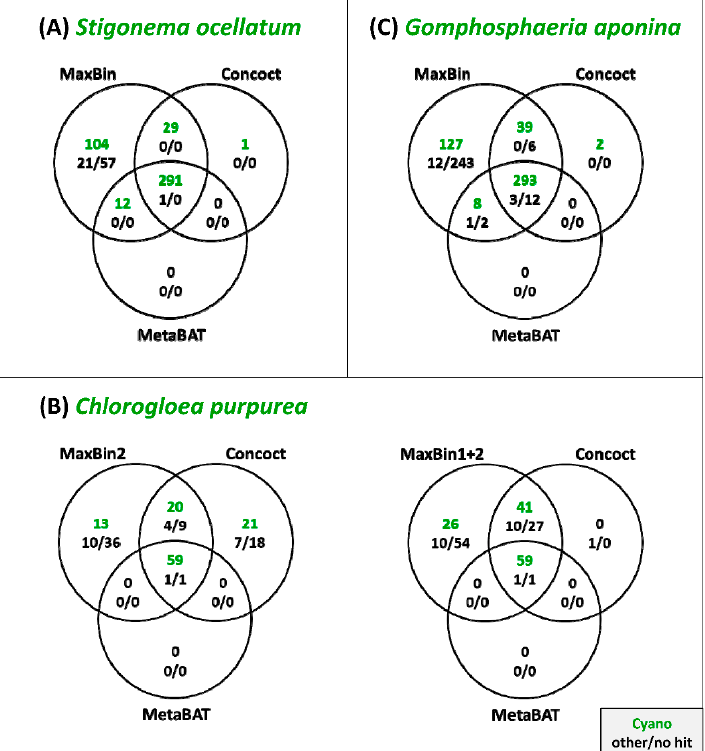
Figure 2. Comparison of cyanobacterial metagenome bins obtained with MaxBin, Concoct and MetaBAT. ( A ) S. ocellatum DSM 106950, ( B ) C. purpurea SAG 13.99, ( C ) G. aponina DSM 107014. The taxonomic affiliation of all contigs was determined with BLASTN searches, which allowed a differentiation between cyanobacterial (Cyano), non-cyanobacterial (other) and contigs without BLAST-results (no hit). Authentic cyanobacterial contigs are highlighted in green.